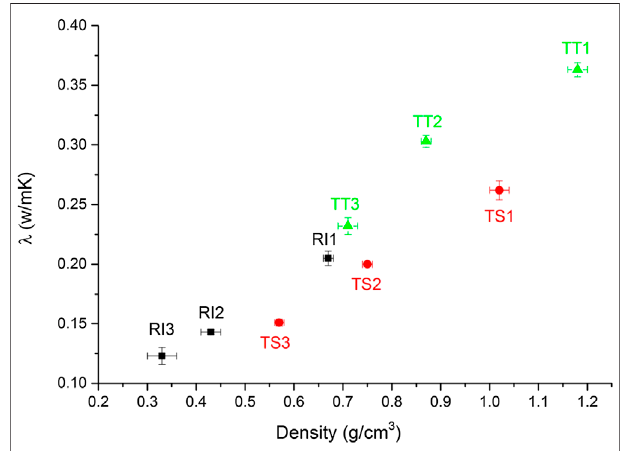
FIGURE 4 | Thermal conductivity properties vs. density in the analyzed alkali-activated foams cured at 70 ° C (RI, TS, and TT fl y ash used, 1, 2, and 3 represent amount of foaming and stabilizing agent used).